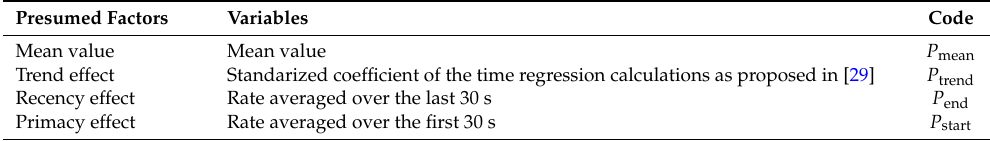
Table 3. Test variables for the multilinear